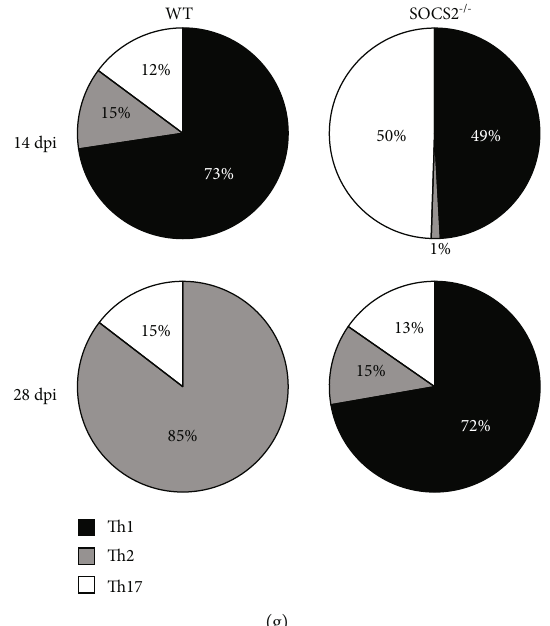
Figure 4: SOCS2 in fl uences the in fi ltrating immune cell pro fi le in the CNS. The spinal cord from WT and SOCS2 -/- naive or immunized (MOG) mice was harvested and submitted to Flow Cytometry analysis at 14 and 28 dpi. Numbers of CD3 + CD4 + (a), CD4 + CD25 hi+ FoxP3 + (b), CD4 + CD3 + IFN- γ + (d), CD3 + CD4 + IL-17 + (e), and CD4 + CD3 + IL-10 + (f) of total population were assessed by Flow Cytometry using speci fi c antibodies as described in Material and Methods. (c) Proportion of CD3 + CD4 + (Th) and CD4 + CD25 hi+ FoxP3 + (Treg). (g) Proportion of CD4 + CD3 + IFN- γ + (Th1), CD3 + CD4 + IL-17 + (Th17), and CD4 + CD3 + IL-10 + (Th2) cells ( n = 6 animals per group). Data are representative of three independent experiments and shown as the mean ± SEM . ∗ p = 0 : 05 , # p = 0 : 05 (comparison between WT EAE 14 days and WT EAE 28